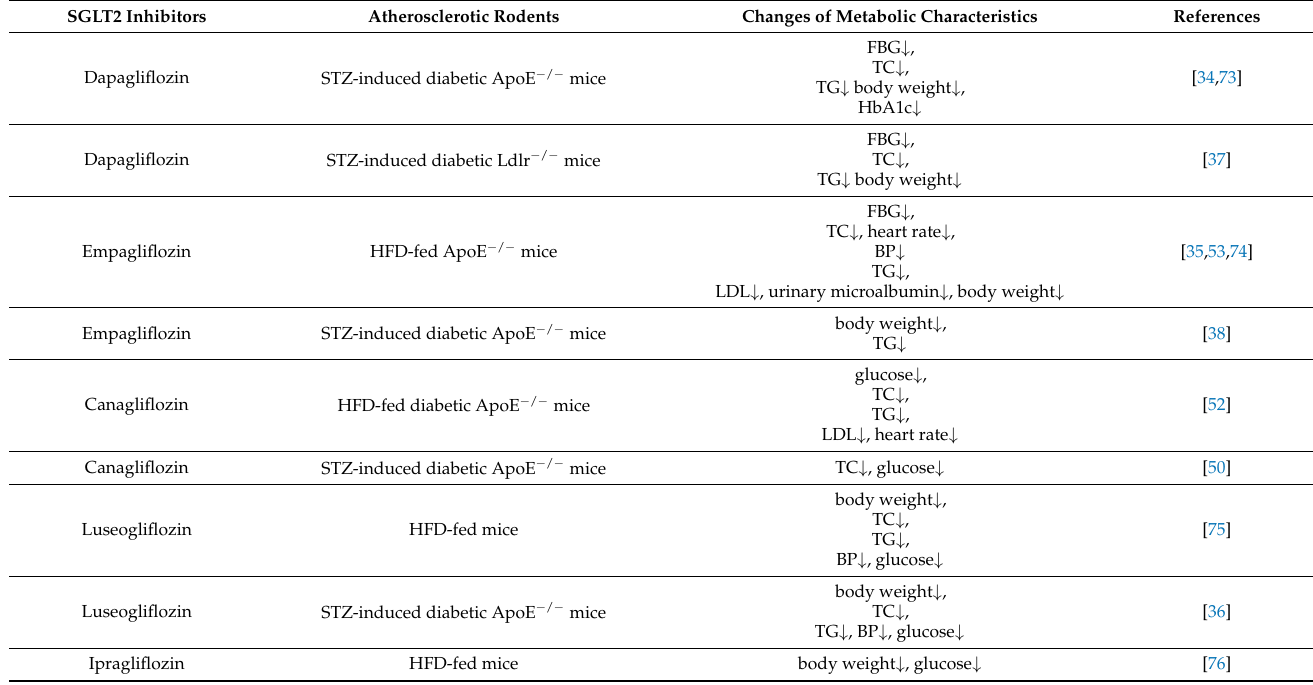
Table 1. Benefits of SGLT2 inhibitors in atherosclerotic